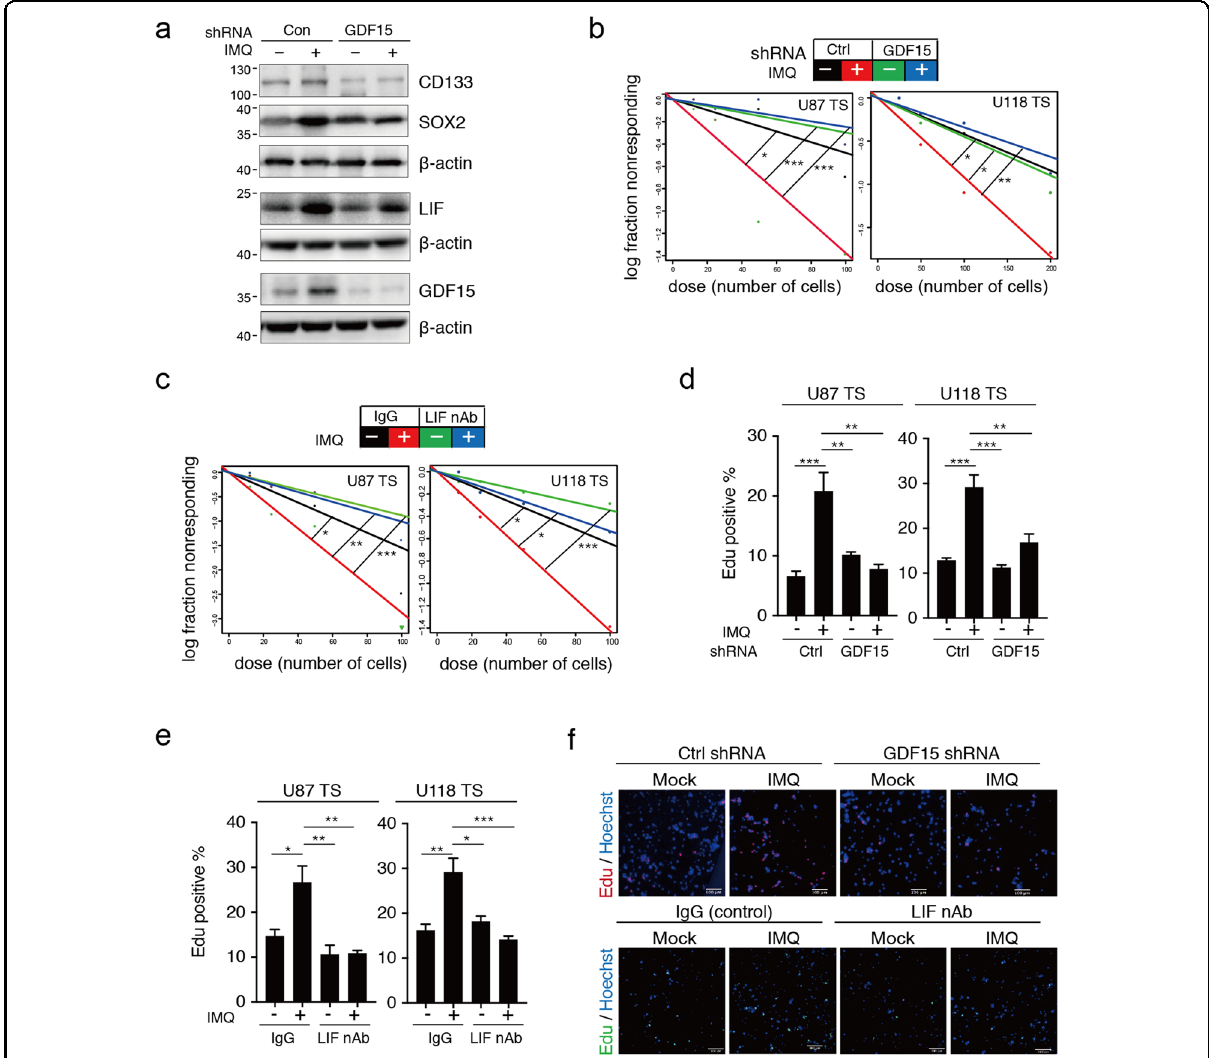
Fig. 4 GDF15 – LIF signaling mediates the GSC-like phenotype of GSC-like cells treated with Imiquimod. a U87 TS cells were treated